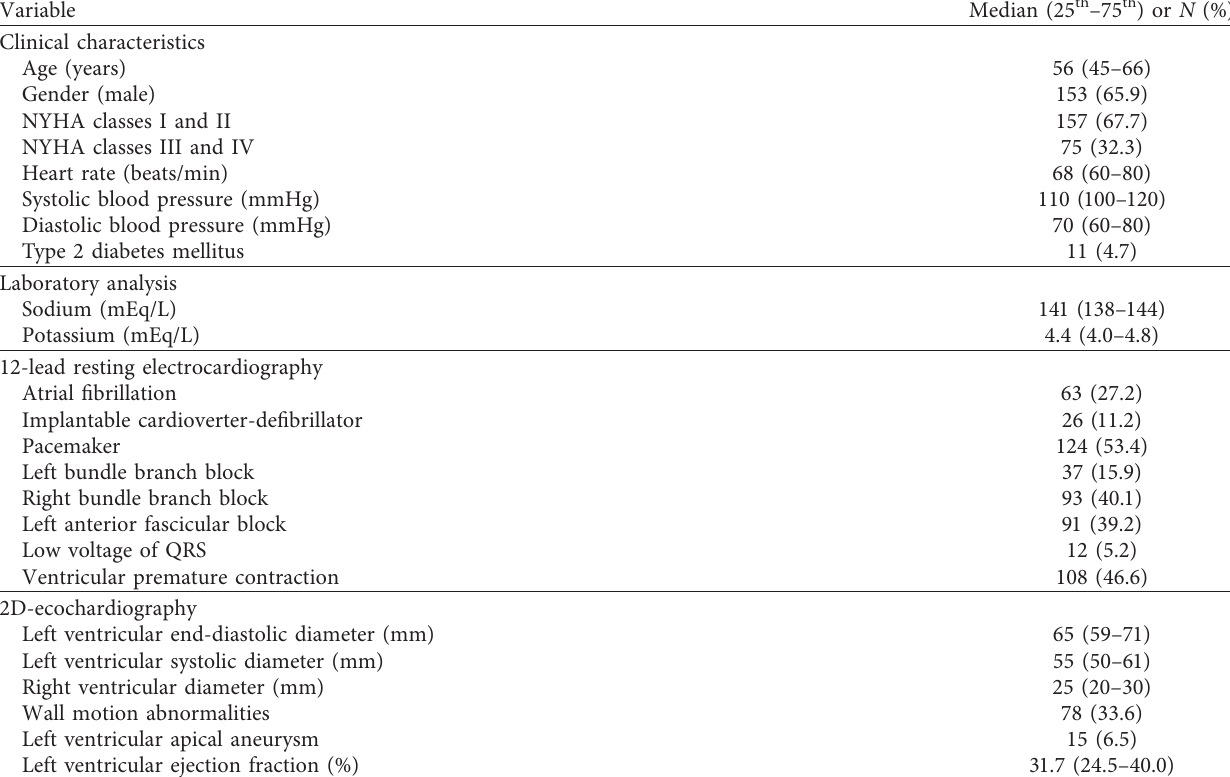
Table 1: Baseline characteristics of Chagas cardiomyopathy prospective cohort ( N �